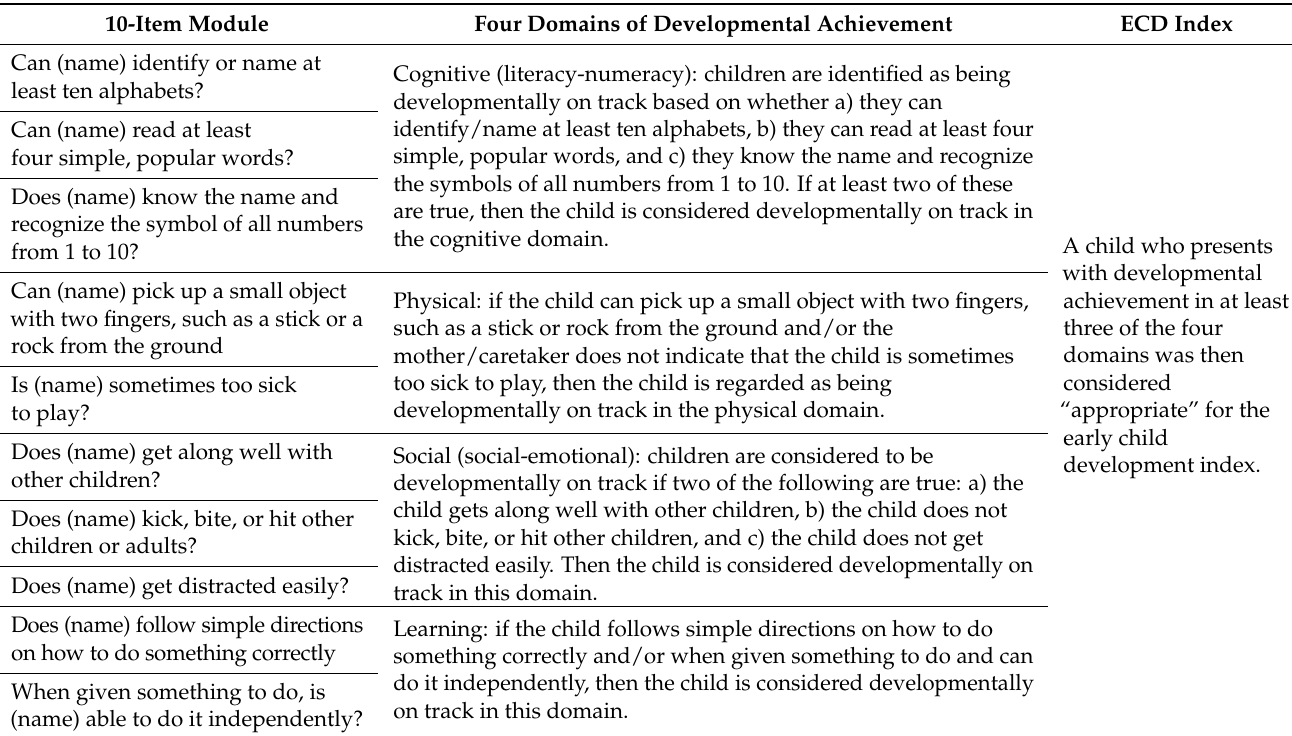
Table 1. 10-item module for the ECD index in the MICS questionnaire for children aged 3–4 years